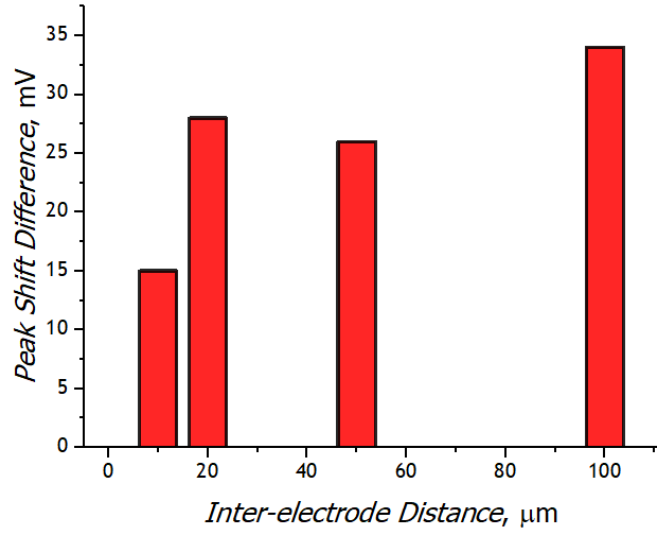
Figure 10. Values of the stationarity parameters of curves with different interelectrode distances in the ensemble.